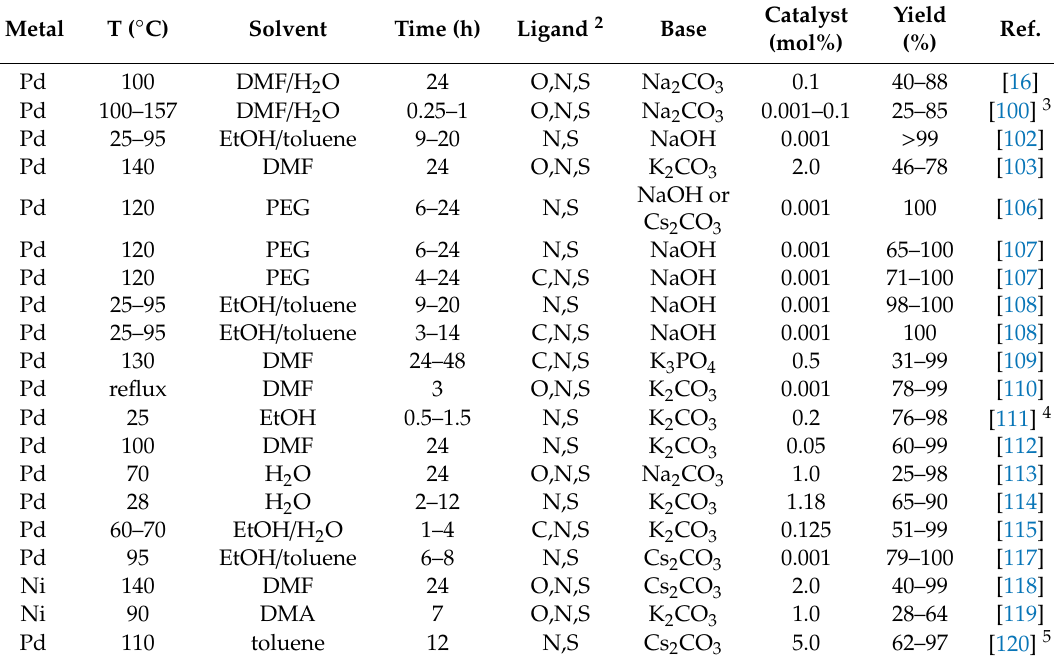
Table 2. Suzuki–Miyaura reactions catalysed by thiosemicarbazone complexes: representative conditions and yields 1